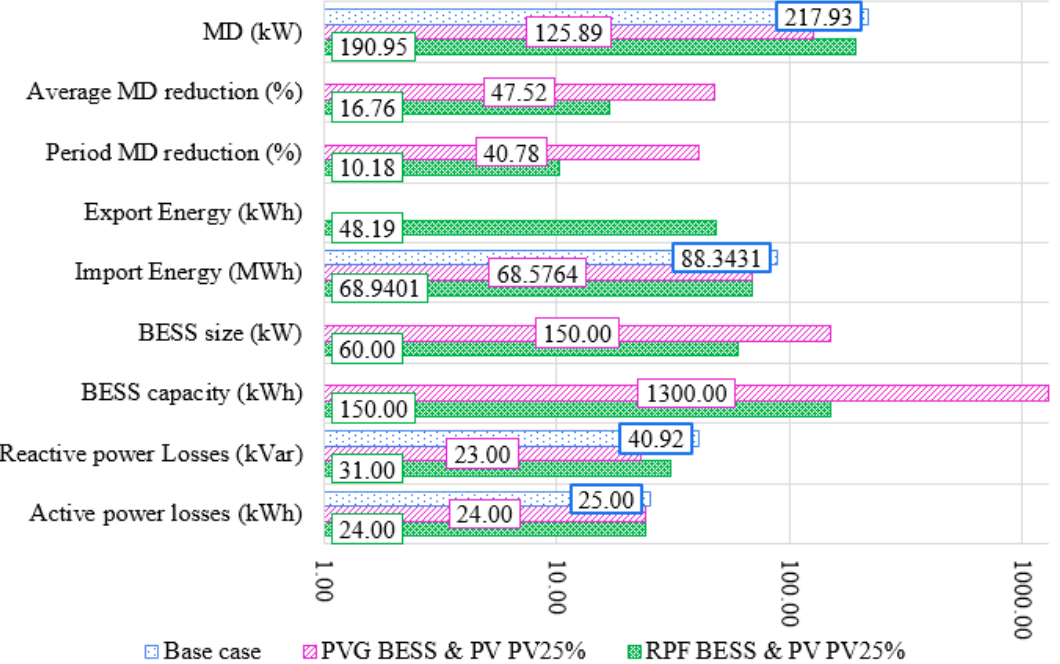
Figure A1. Comparison of PVGS and RPFS with 25% PV penetration level (January 2016).